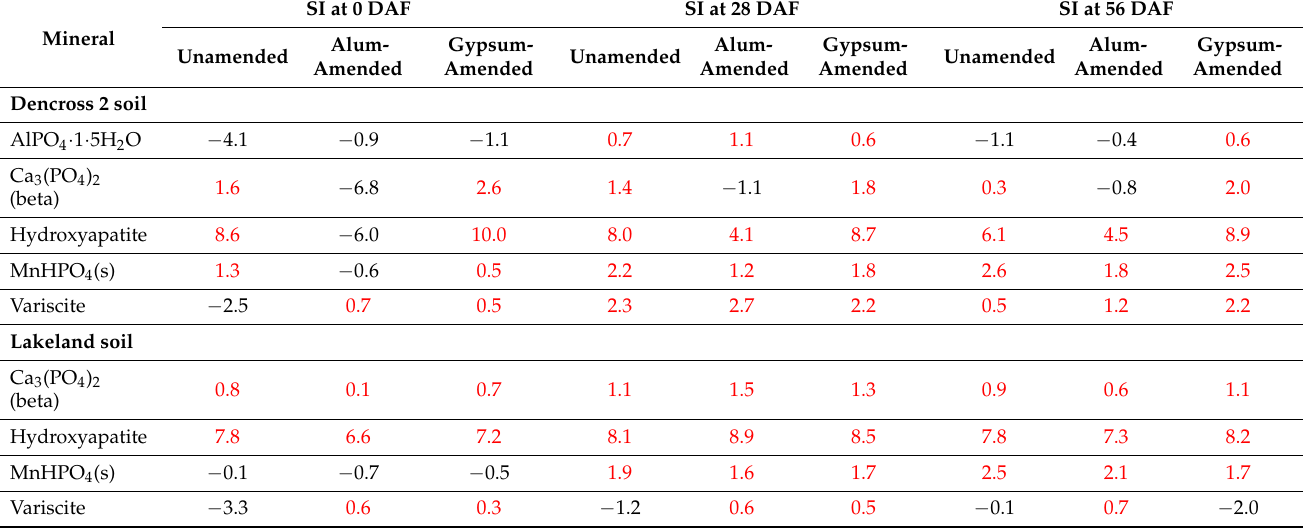
Table 1. Saturation index values † (SI = log IAP–log K sp ) of P minerals in equilibrium solution in unamended (control), alum-amended and gypsum amended soils at 0, 28 and 56 days after flooding (DAF) as predicted by Visual MINTEQ